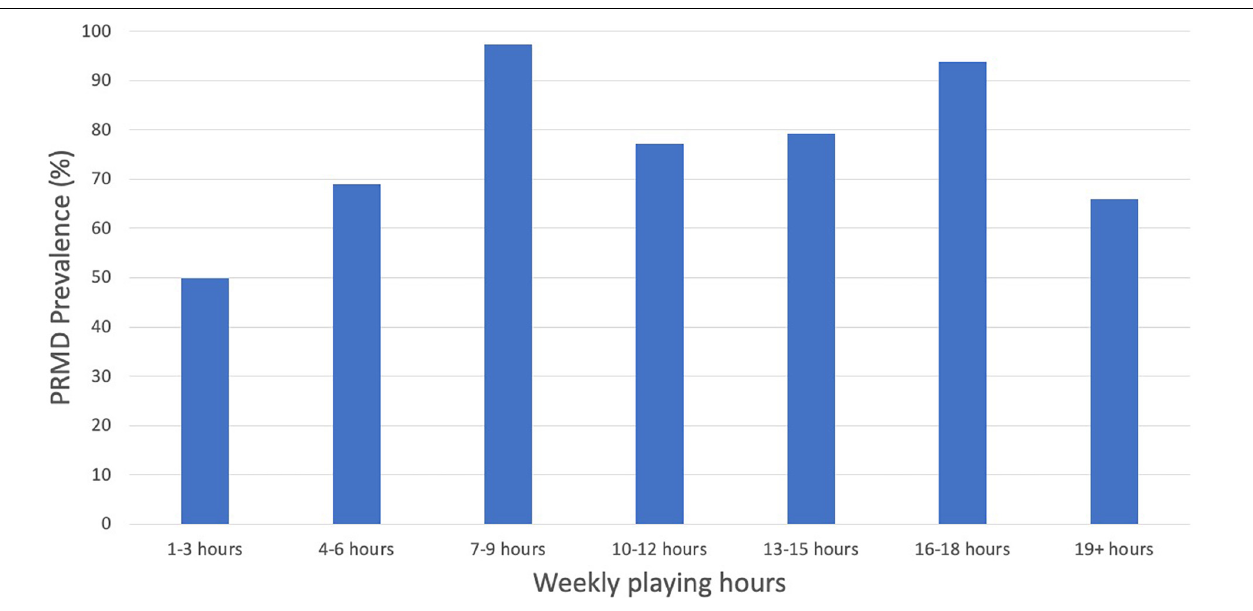
FIGURE 7 | PRMD prevalence (%) by weekly playing